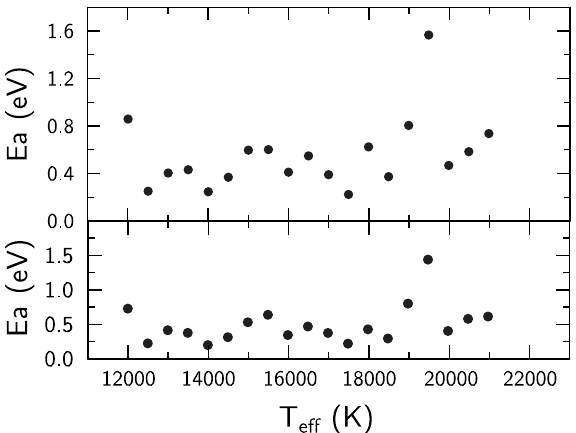
Fig. 4. Absorbed energy of the Mg II lines at (cid:21) = 2795.523 ˚A (top) and (cid:21) = 2802.698 ˚A (bottom) vs. T eff .